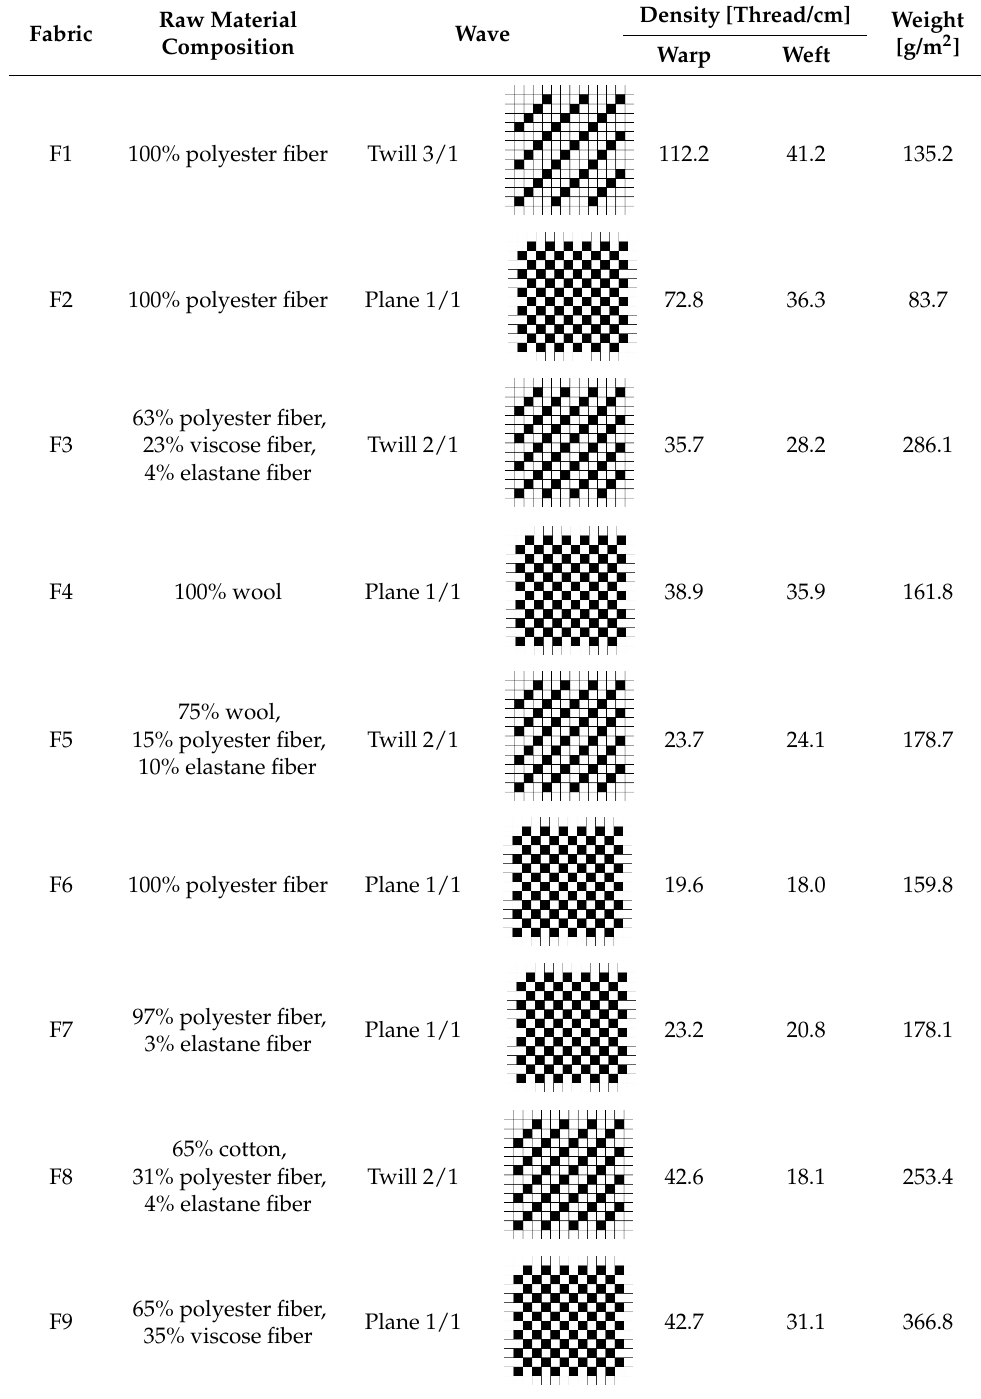
Table 1. Structure of selected fabrics according to raw material composition, wave, thread density, and fabric weight.